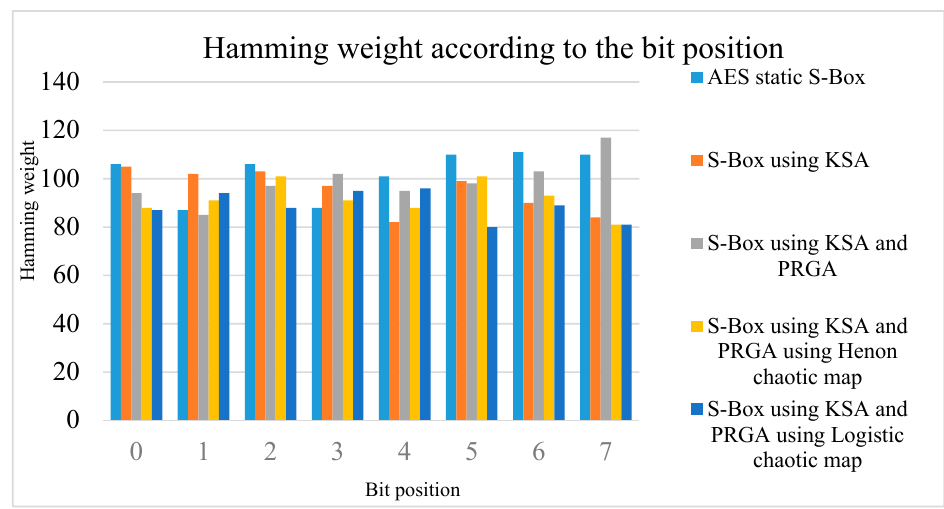
Figure 7. Analysis of Hamming weights according to the bit position for the five S-Boxes.